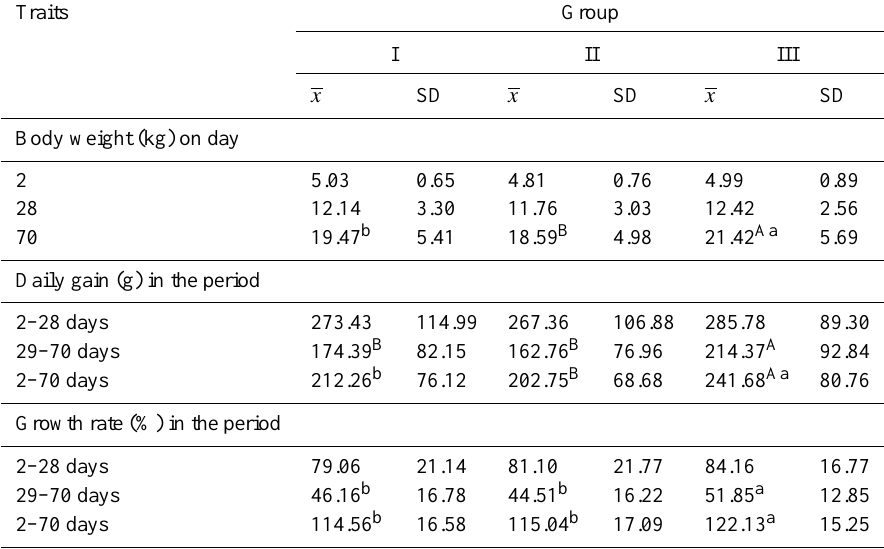
Table 3. Body weight, daily gain and growth rate of lambs. Traits